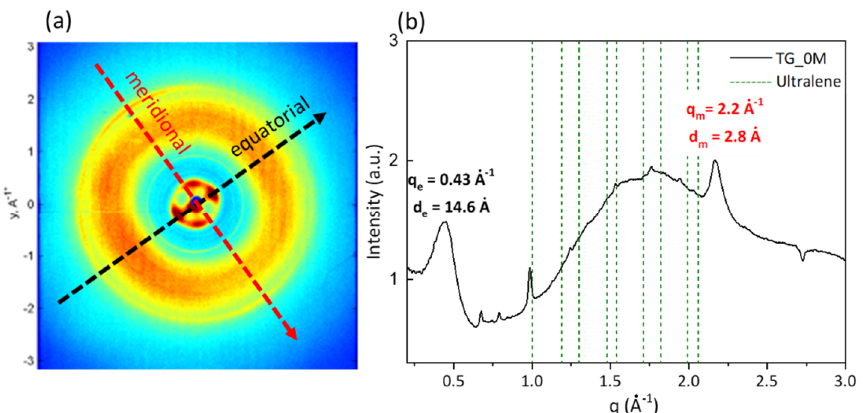
Figure 1. Two-dimensional WAXS diffraction pattern of Tilapia skin from the control fish ( a ) shows the equatorial (black arrow) and meridional (red arrow) directions identified by the peak positions in the corresponding ( b ) 1D diffraction pattern. Vertical dotted bars refer to Ultralene ® sachet diffraction. (See Figure S3 in the Supplementary Materials).